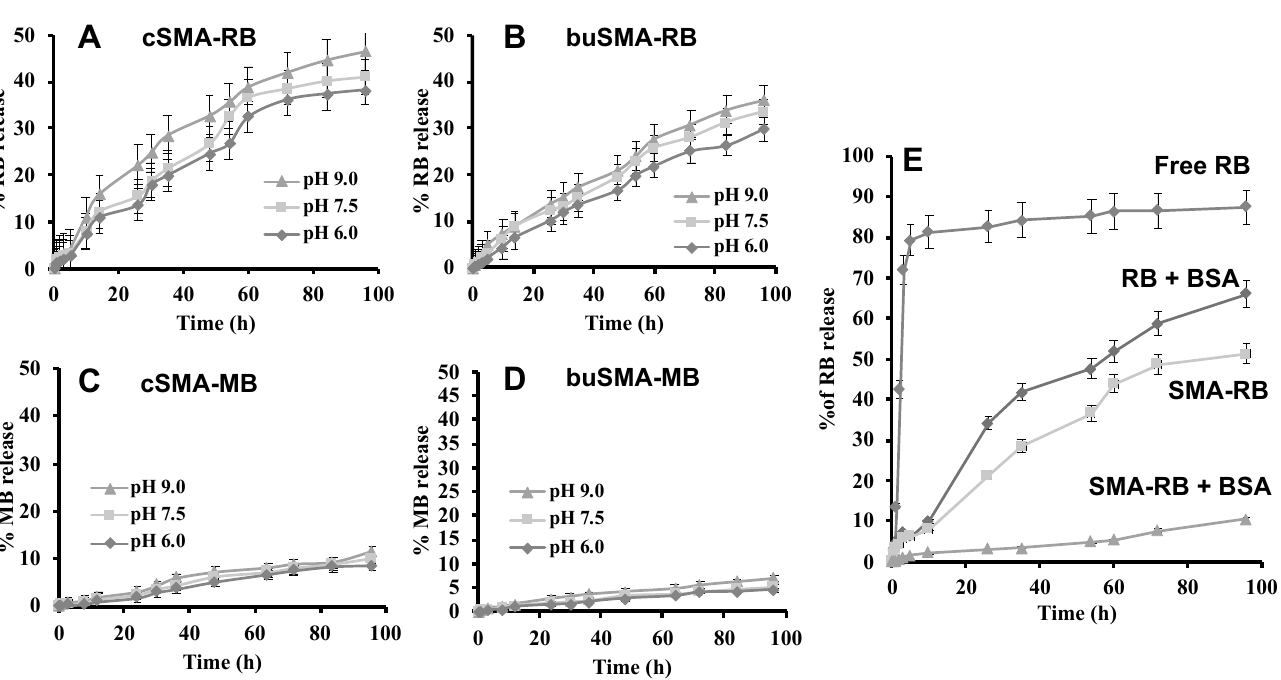
Figure 4. Release profiles of SMA-PS micelles; cSMA-RB ( A ), buSMA-RB ( B ), cSMA-MB ( C ), buSMA-MB ( D ), and SMA-RB micelles in the presence of bovine serum albumin (BSA) ( E ). SMA-PS micelles were dissolved in deionized water and sealed in a dialysis tube. At the indicated time after incubating at 37 ◦ C, UV absorption at 549.0 nm and 664.0 nm corresponding to RB and MB was measured in the dialysate. Constant release rate from both cSMA-RB and buSMA-RB was observed at neutral pH. The release from cSMA-MB and buSMA-MB is considerably lower than cSMA-RB and buSMA-RB micelles (see text for details). Data are mean ± SD ( n = 3).